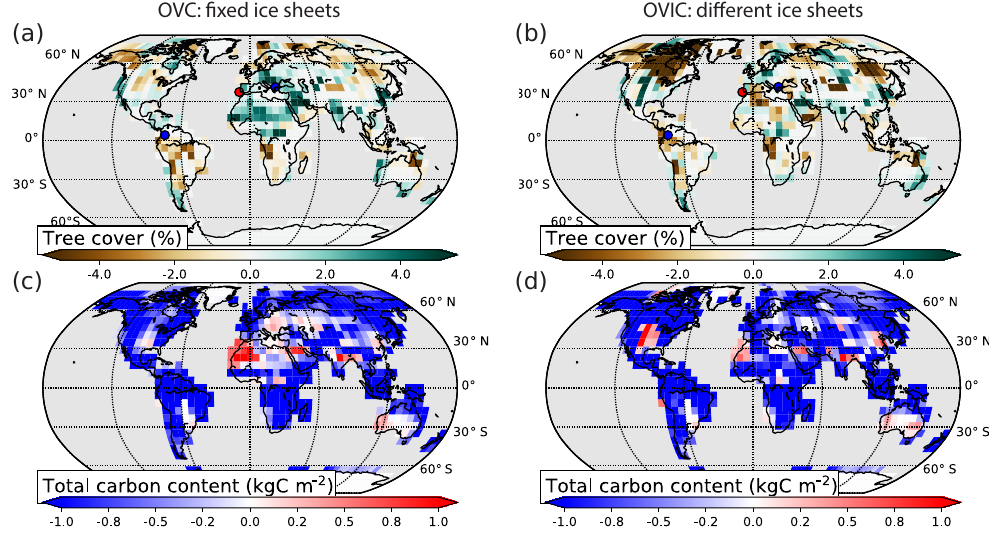
Figure 12. (a,b) Tree cover (%) and (c,d) carbon storage (kgCm − 2 ) difference between pre-MBE (MIS 13, 15, 17, 19) and post-MBE (MIS 5, 7, 9, 11) interglacial simulations for (a,c) the OVC series with interactive vegetation and fixed ice sheets and (b,d) the OVIC series with interactive vegetation and different ice sheets. Qualitative indication of tree cover change from data is indicated with dots: blue indicates a reduction of tree cover on average during pre-MBE interglacials compared to post-MBE interglacials, and red indicates an increase.